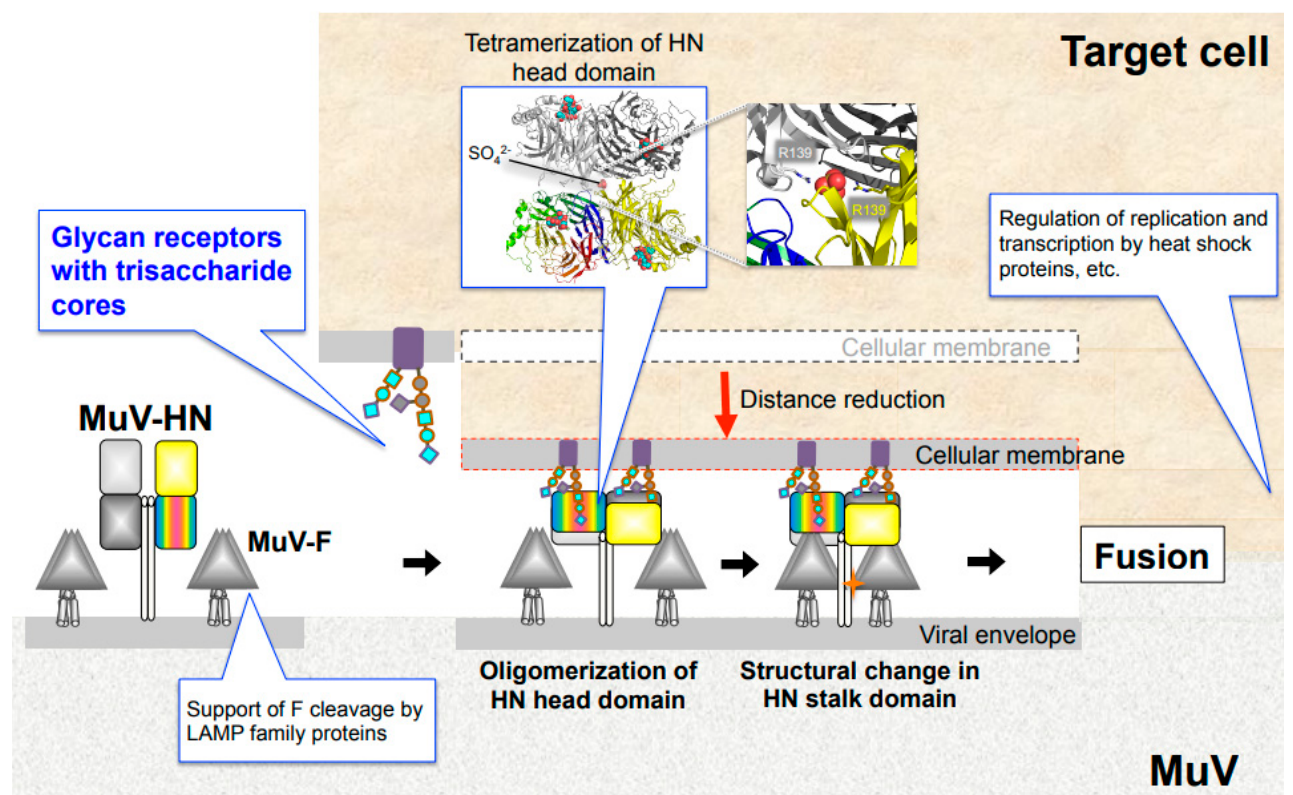
Figure 3. MuV entry mechanism and host factors. Binding of MuV-HN to glycan receptors causes sequential conformational changes in the HN and F proteins, leading to membrane fusion. Multimerization of the MuV-HN head domain upon receptor binding may affect the structural change of the MuV-HN stalk domain, which in turn may trigger the structural change of the F protein. Following cellular entry, replication and transcription of the viral genome are regulated by host factors, such as heat shock protein family. LAMP family proteins support furin-mediated cleavage of the newly synthesized F protein.